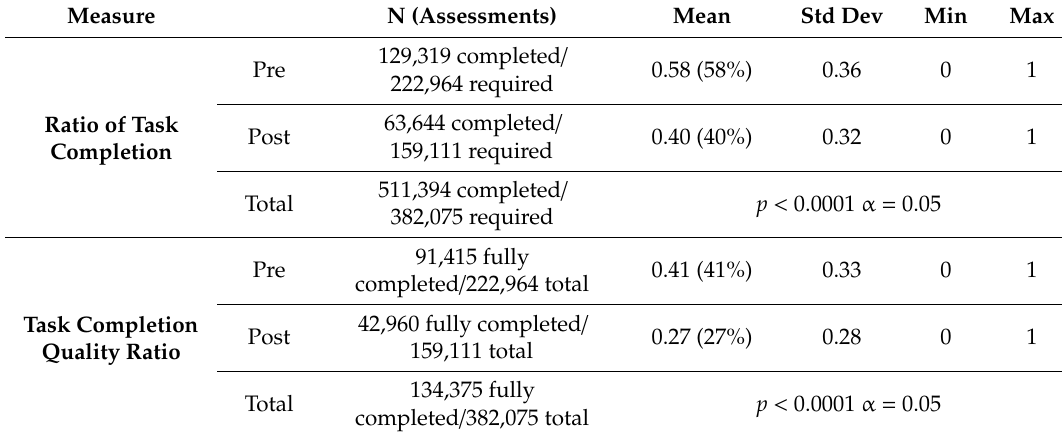
Table 4. Task Completion Pre- and Post-Storyboard Implementation.